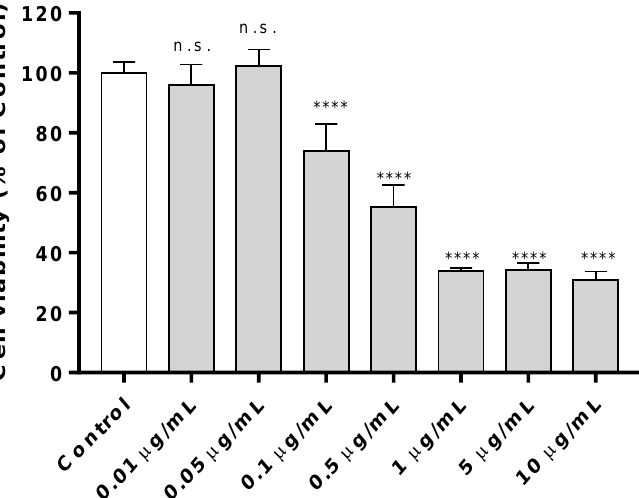
Figure 3. Human keratinocyte HaCaT cell viability after 12 h exposure to GNPs at different concen- trations (from 0 µg/mL (control sample) to 10 µg/mL) measured by the (3-(4, 5-dimethylthiazol-2- yl)-2, 5-diphenyl tetrazolium) (MTT) assay. Results are expressed as % of the control sample and as the mean ± standard deviation of six replicates. The results of the statistical analysis with respect to control are indicated in the graph: **** p < 0.0001; n.s: not significant. The limit is 70% of cell viability for the materials to be considered non-cytotoxic according to the ISO-10993 standard. The cytotoxicity results at 24 h-exposure of GNPs in HaCaT cells showed also signif- icant non-cytotoxicity for concentrations ≤0.05 µg/mL (Figure 4).